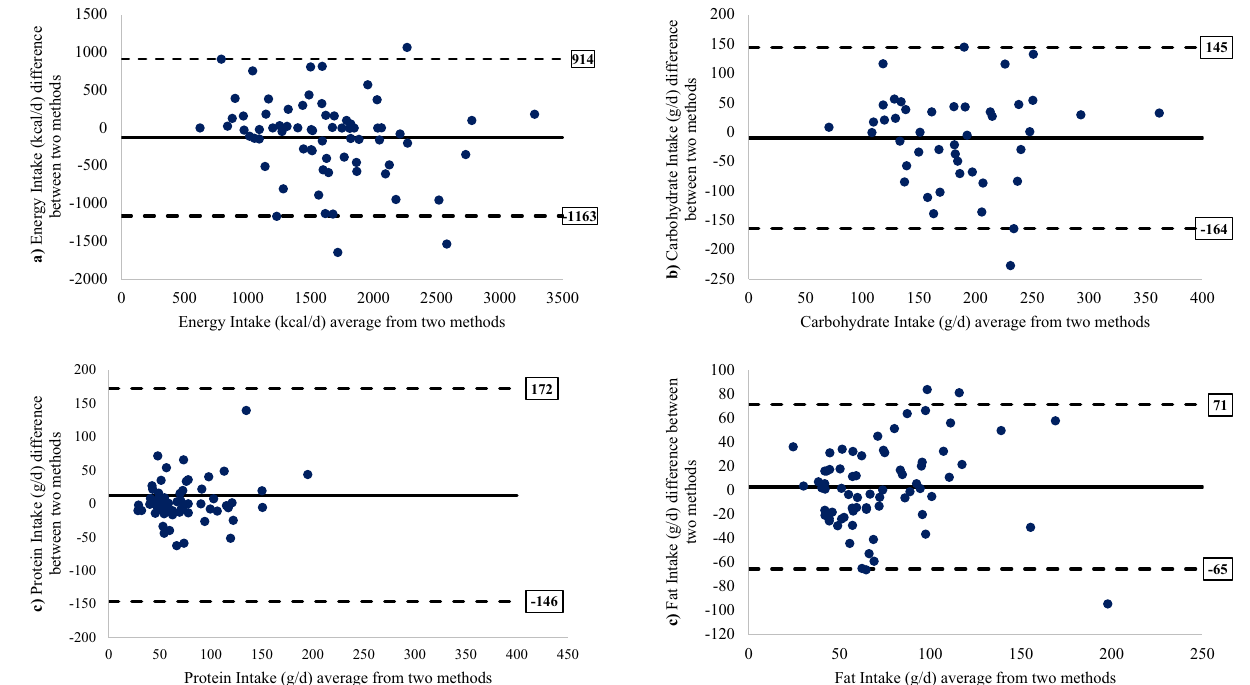
Figure 2. Bland–Altman plots showing mean difference (3-DFR—Ghithaona app, solid line) vs. mean intakes ((3-DFR + Ghithaona app)/2) for ( a ) energy; ( b ) carbohydrate; ( c ) protein; ( d ) fat. The dotted lines indicate the 95% limits of agreement (SD 1.96).